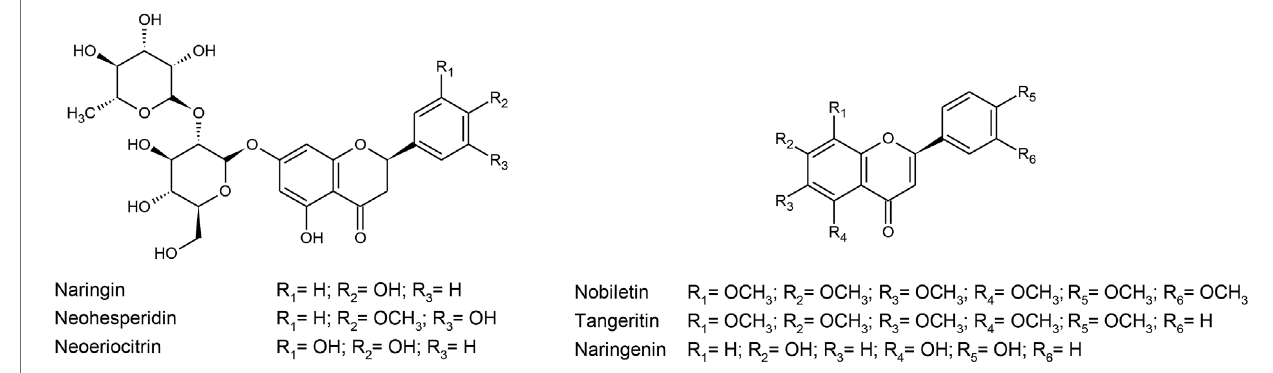
FIGURE 2 | Chemical structure of the main fl avonoids found in Citrus .